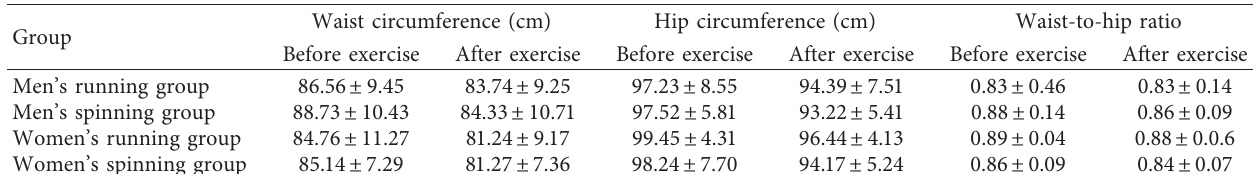
Table 3: Changes in waist-to-hip ratio in patients with dyslipidemia before and after exercise. Waist circumference (cm) Hip circumference (cm) Waist-to-hip ratio Group Before exercise After exercise Before exercise After exercise Before exercise After exercise